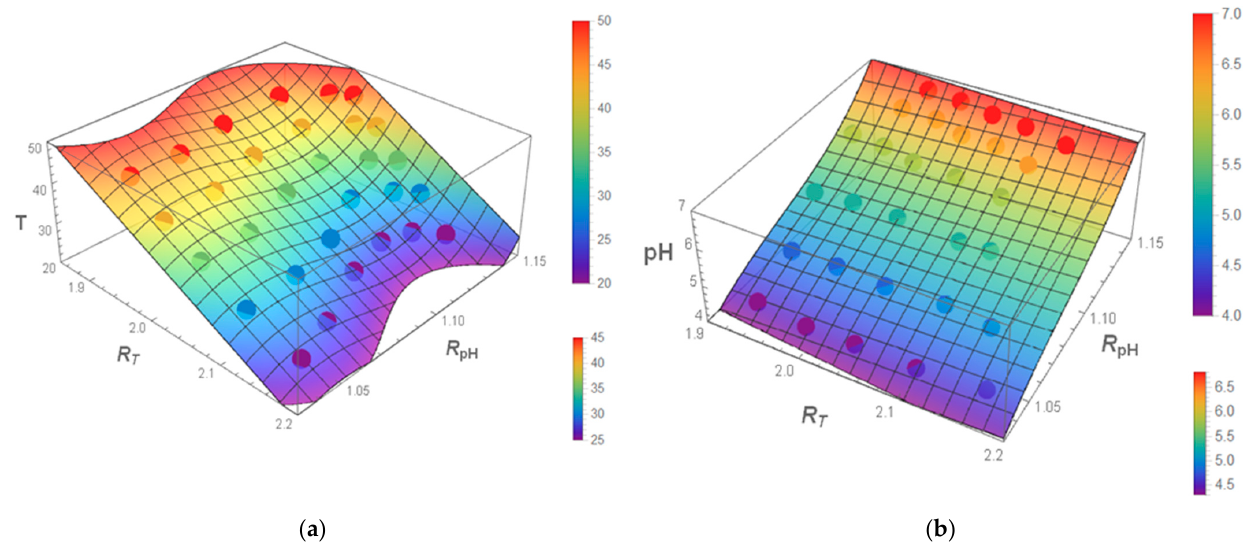
Figure 8. The results of the multiparametric fitting of experimental data (shown by dots) using Equations (4) and (5) to measure measuring temperature and pH, respectively. The measurements of the ( a ) temperature and ( b ) pH as a function of two ratios, R T and R pH .